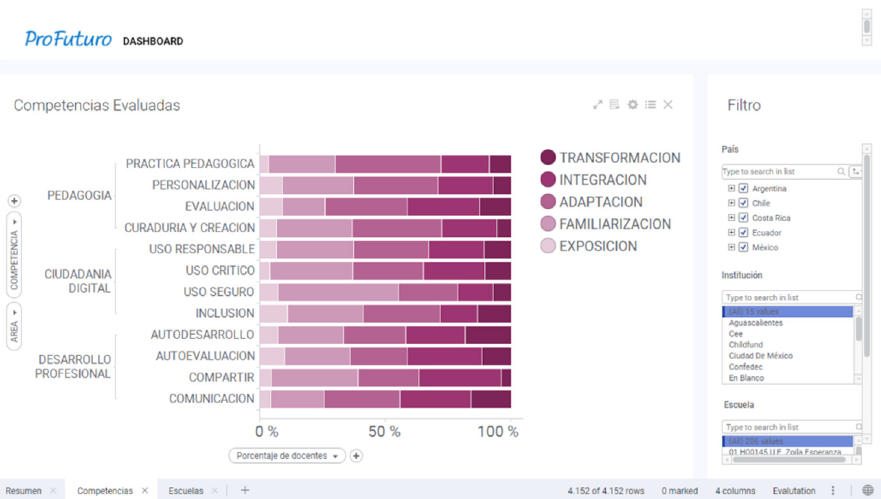
Figure 11. Distribution of teachers in each skill in accordance with the level of appropriation.